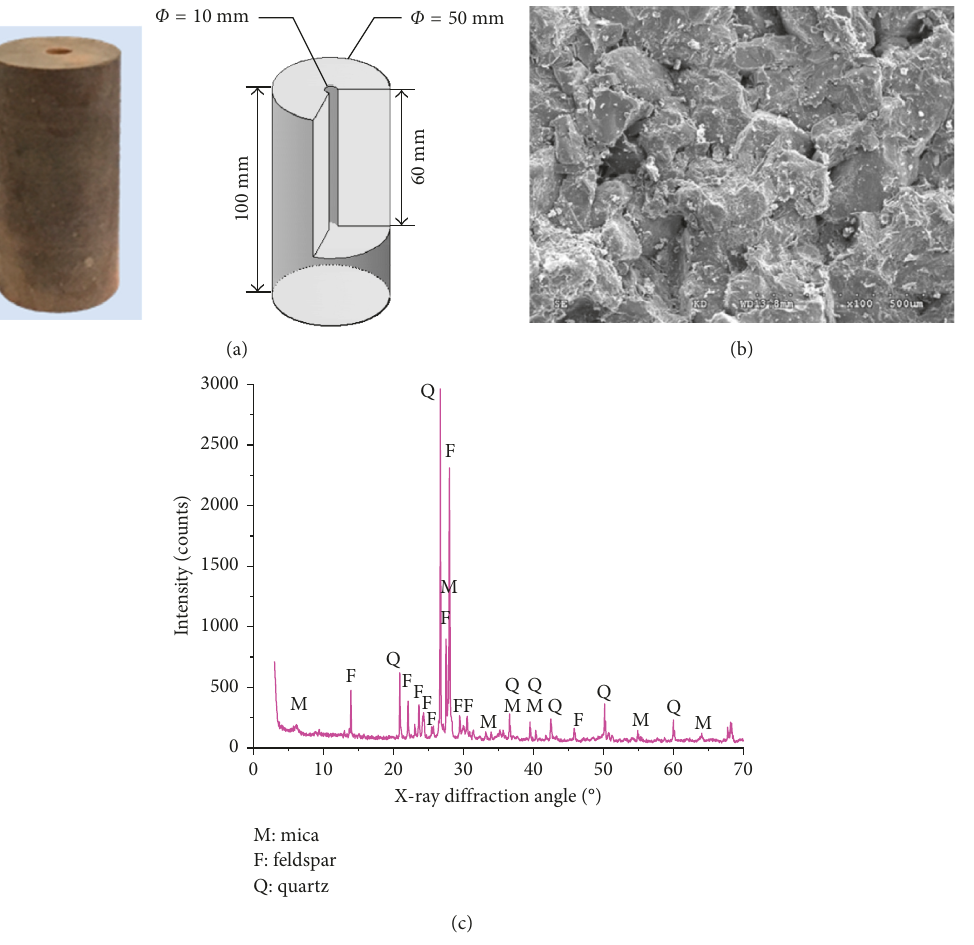
Figure 1: Preparation and mesoscopic tests of the red sandstone specimen. (a) Specimen design. (b) Scanning electron microscope (SEM) pattern of specimen. (c) Analysis of X-ray